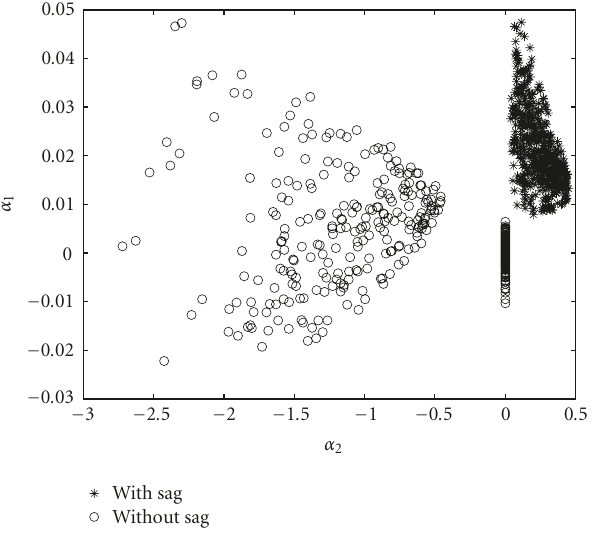
Figure 19: HOS-based features extracted from vector f for sag α 1 = α (cid:21) c = (cid:9) c 4, f (512) and 2 2, f (194).